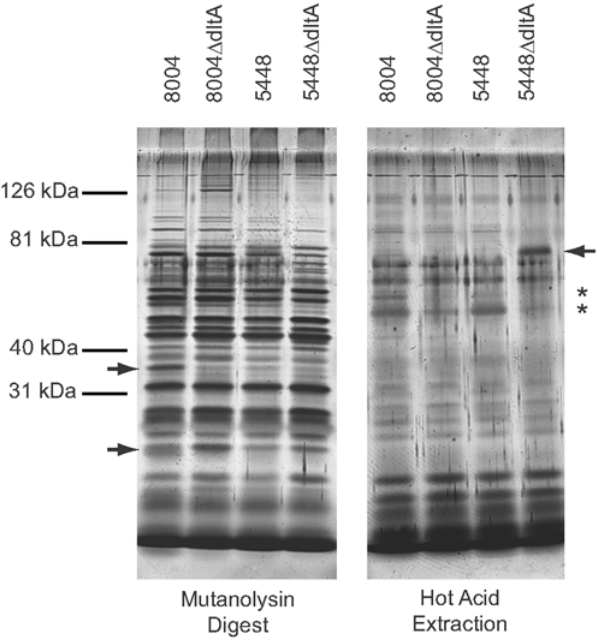
Figure 1. Cell wall protein extracts of parent and D dltA mutants. Bacteria were grown to mid-log phase and subjected either to lysozyme-mutanolysin digestion or hot acid extraction to obtain cell wall proteins. The material obtained was analyzed by SDS-PAGE followed by silver staining. Asterisks indicate positions where major M protein bands would migrate. Arrows indicate other proteins whose expression also appears to be altered in mutant compared to WT